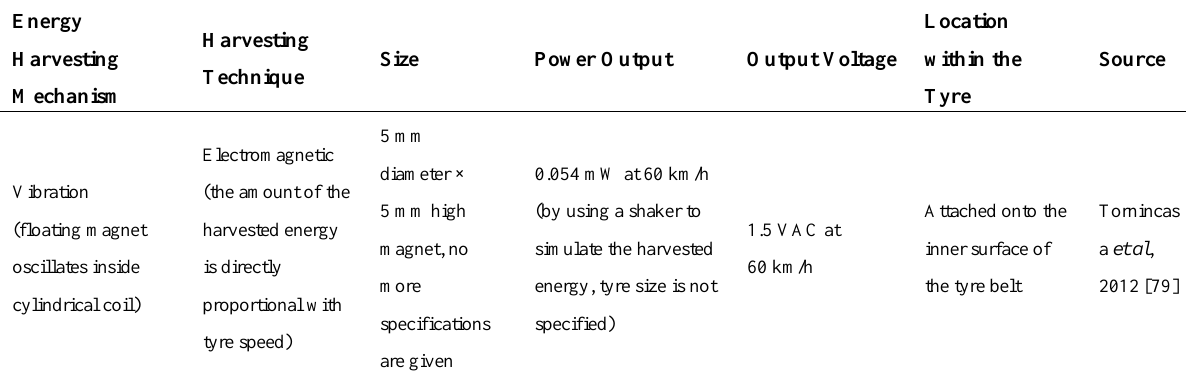
Table 5. Summary of published research for energy harvesters designed potentially for self-powered